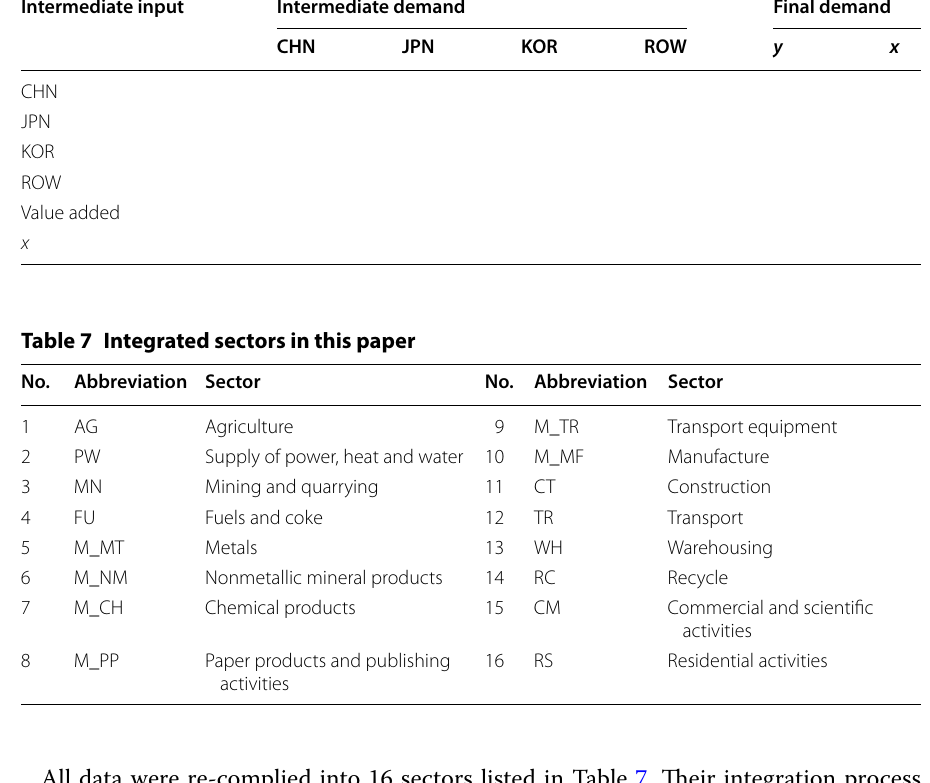
Table 6 Trilateral input–output table of China, Japan and Korea Intermediate input